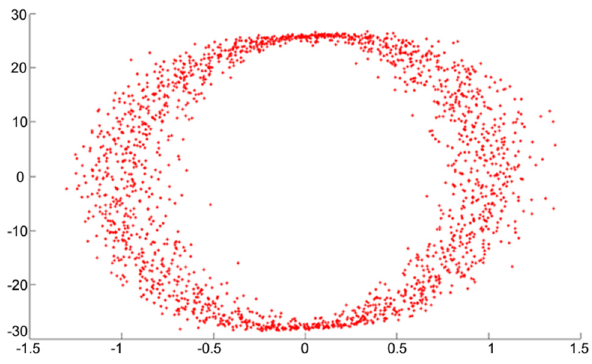
Figure 9. Chaotic trajectory for normal power system signal.